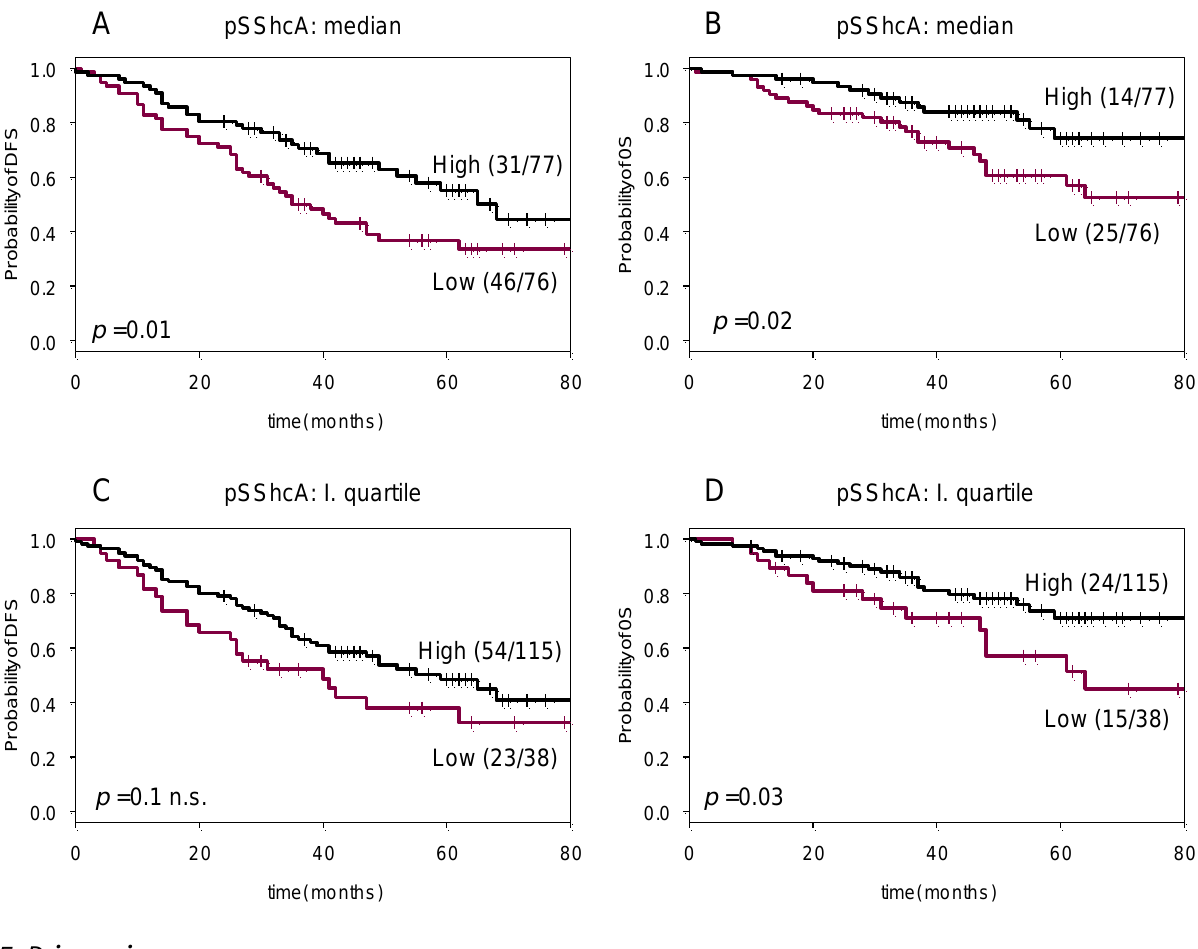
Figure 4. Kaplan–Meier survival curves for pSShcA. Patients were dichotomized according to the median ( A , B ) or first quartile expression value of pSShcA ( C , D ). Disease-free survival (DFS) ( A , C ) and overall survival (OS) in ( B , D